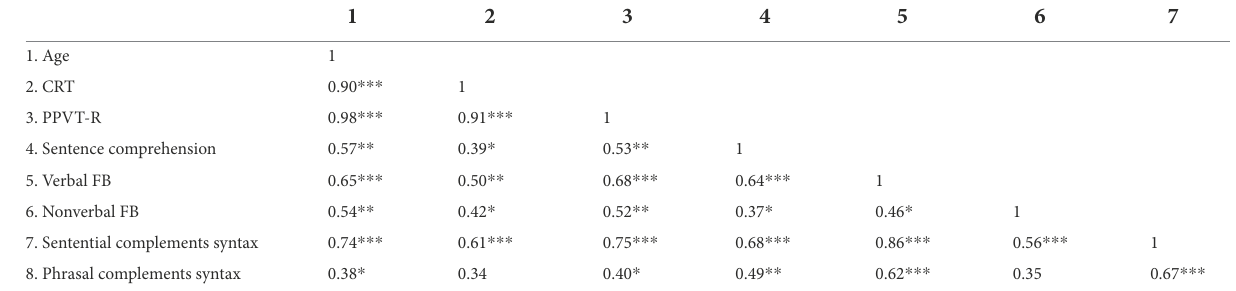
TABLE 4 Simple correlations results for the TD children.